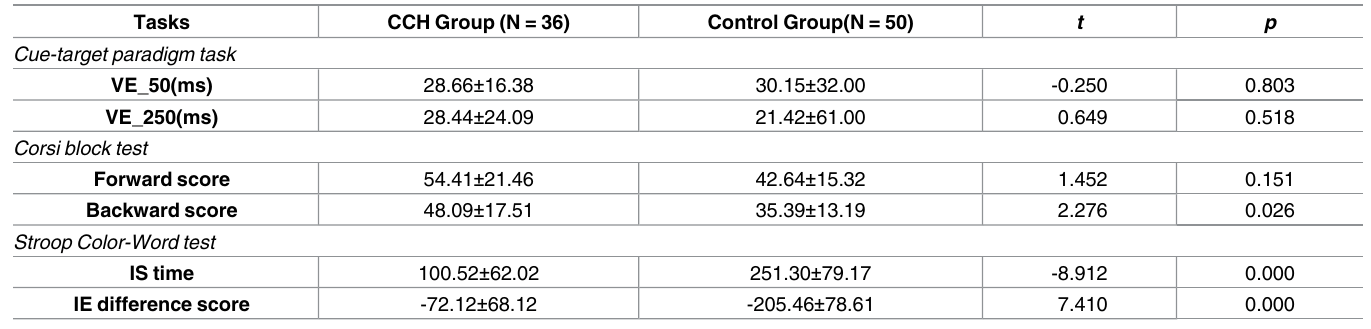
Table 3. Group differences in the cue-target paradigm task, Corsi block test, and Stroop color-word test. Tasks